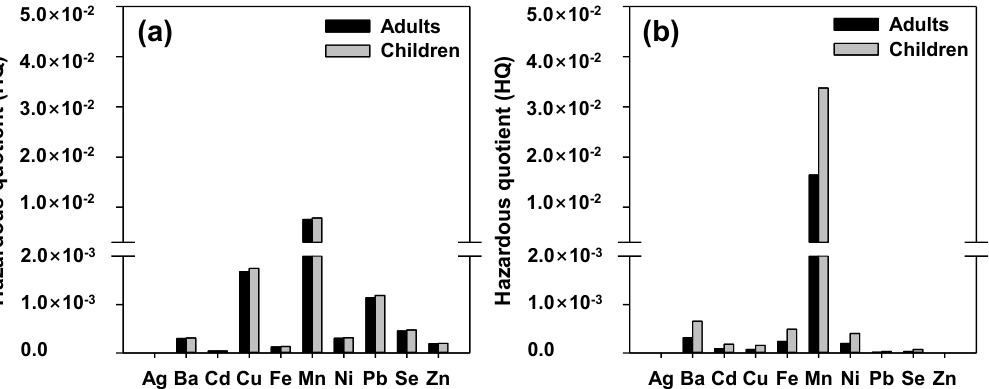
Figure 5. Hazardous quotient (HQ) for both ( a ) ingestion rate and ( b ) dermal adsorption of adults and children in the Han River watershed.